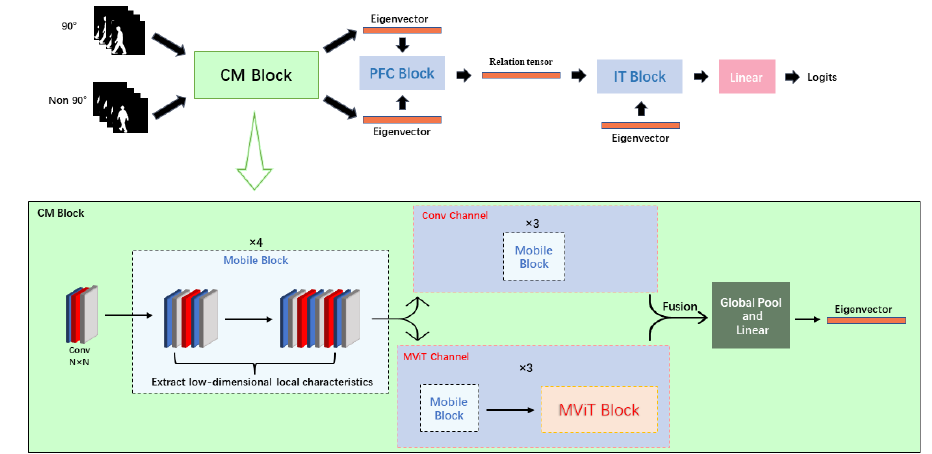
Figure 1. Structure diagram of SMViT.